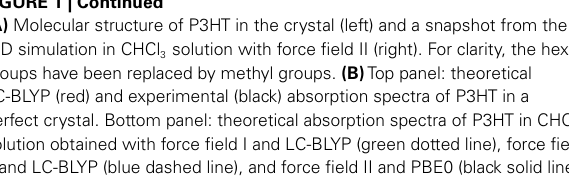
compared to the experimental spectrum (black solid line) (Rahimi et al., 2014). (C) Dependence of the position of the main absorption peak of planar P3HT oligomers on the repetition length n .The black circles have been obtained fromTDDFT/LC-BLYP/6-31 + G* calculations, while the red line is a Kuhn